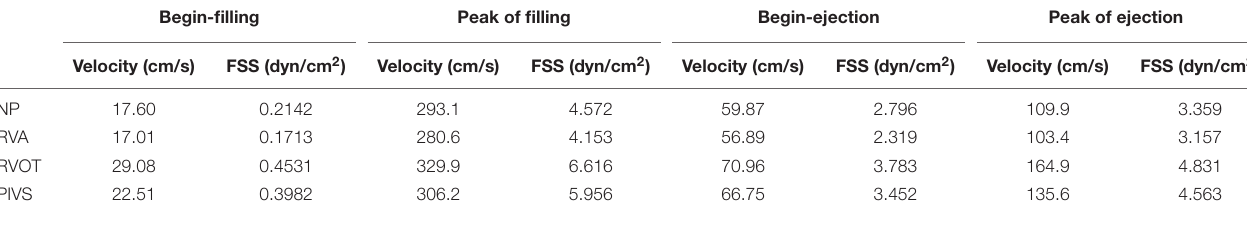
TABLE 3 | Velocity and flow shear stress (FSS) mean values at different times from 4 pacing